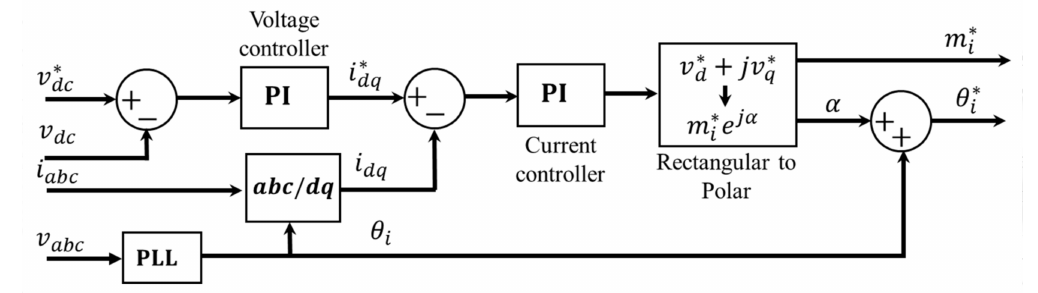
Figure 6. DC-link voltage control for the grid side converter.